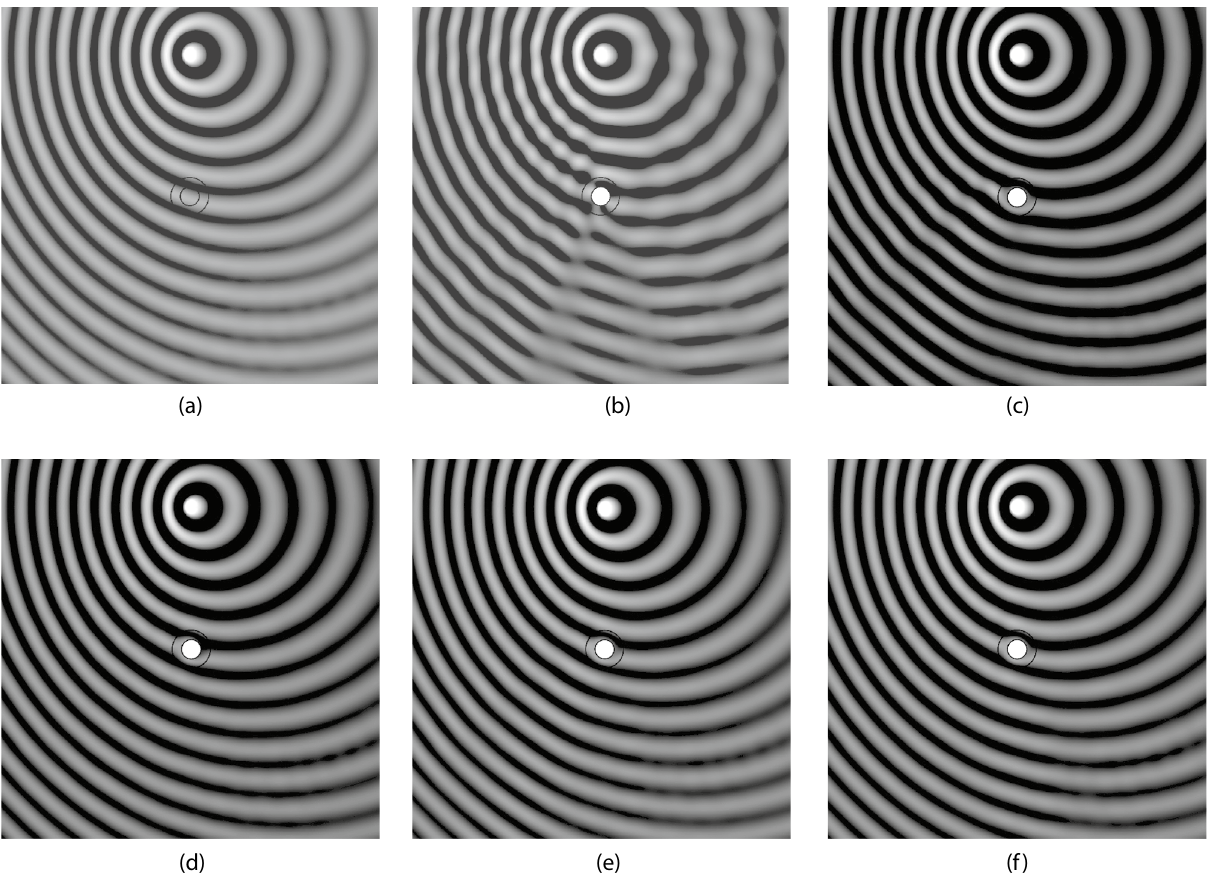
0.3 for kr 2 4 . ( a ) shows the undisturbed = ∞ =